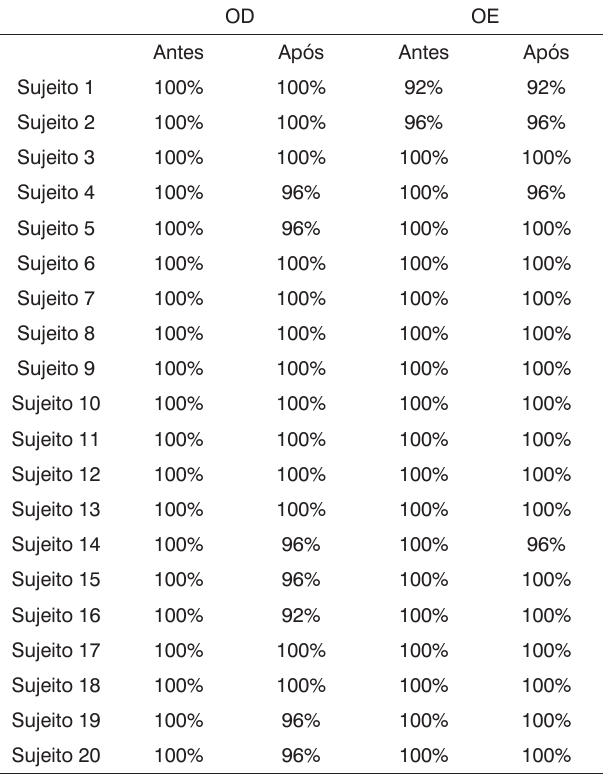
Tabela 1. Resultados referentes ao questionário acerca da saúde auditiva